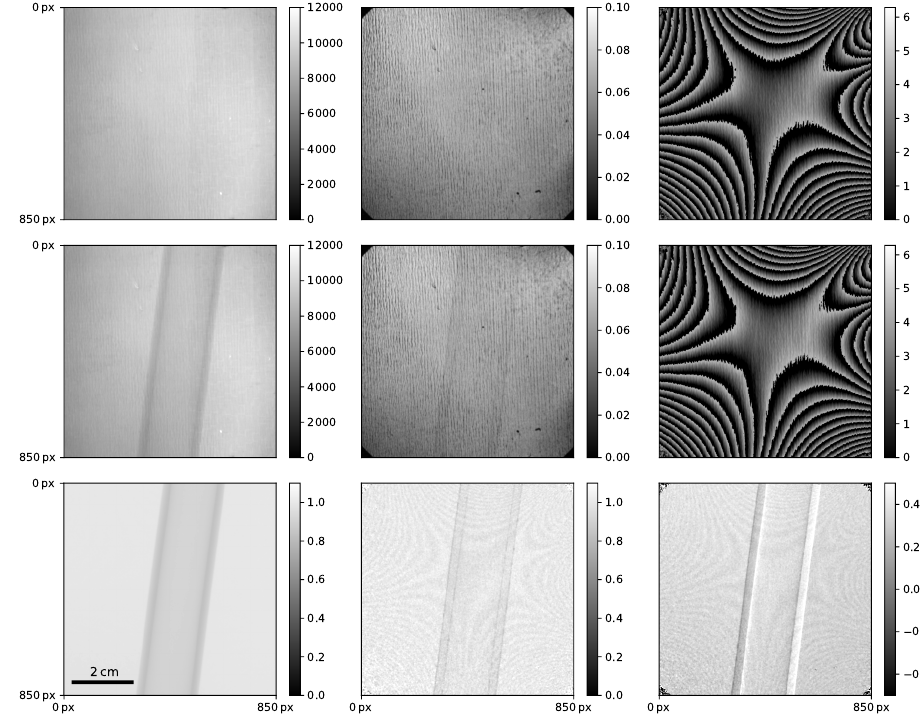
Figure 2. From left to right: Transmission (sinusoid mean), visibility (ratio of sinusoid amplitude and mean) and phase images derived from phase stepping series, as shown in Figure 1. The first two rows show acquisitions with and without sample (a piece of plastic hose of 2cm diameter), while the last row shows the sample images (center row) normalized with respect to the empty beam images (first row). Positioning errors in the phase stepping procedure cause the Moiré pattern of the reference phase image to translate into the final